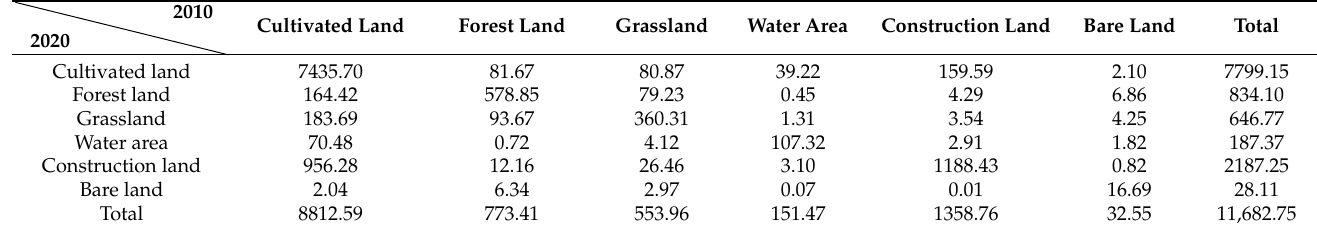
Table 14. The land use transfer matrix in Jinan from 2010 to 2020 (unit: km 2